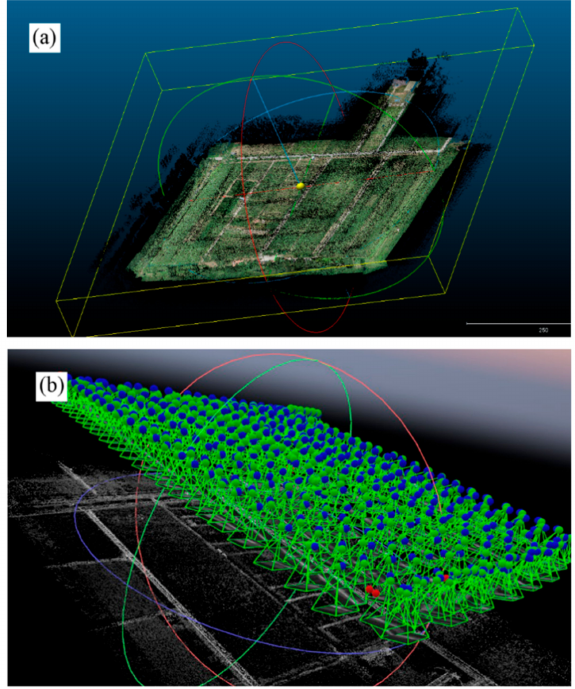
Figure 4. ( a ) The Light Detection and Ranging (LiDAR) point clouds and ( b ) the multispectral Structure from Motion (SfM) point clouds of the study